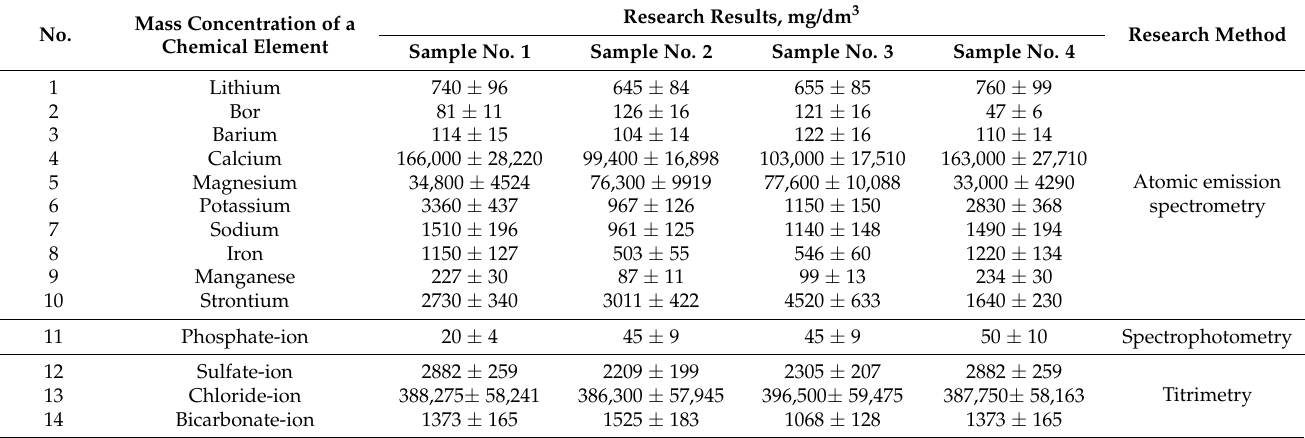
Table 1. Results of the analysis of the dry residue of formation fluid by the method of standard